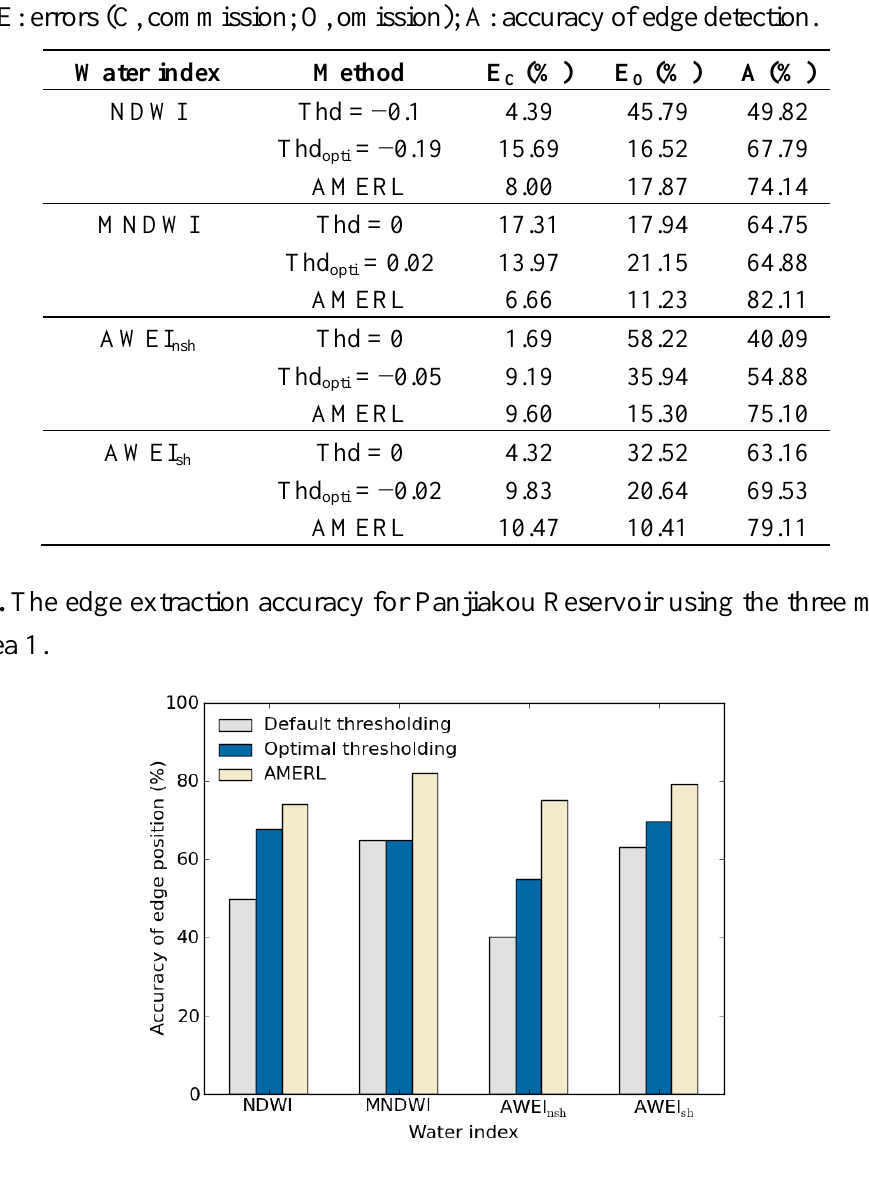
Table 5. Edge extraction accuracy assessment for Panjiakou Reservoir using the default